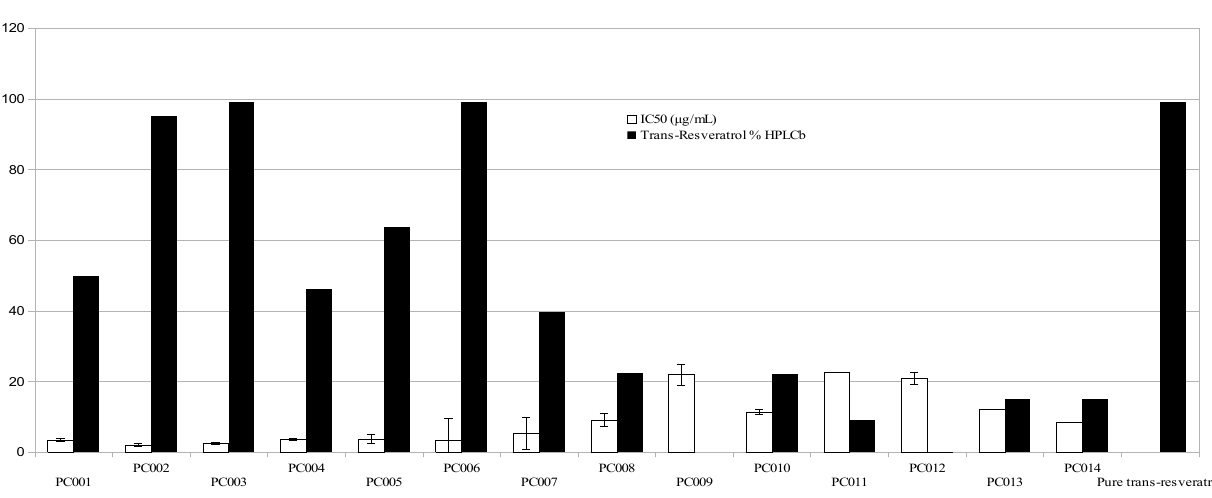
Figure 1. Effects of Resveratrol Commercial Product on Cell Growth of K562